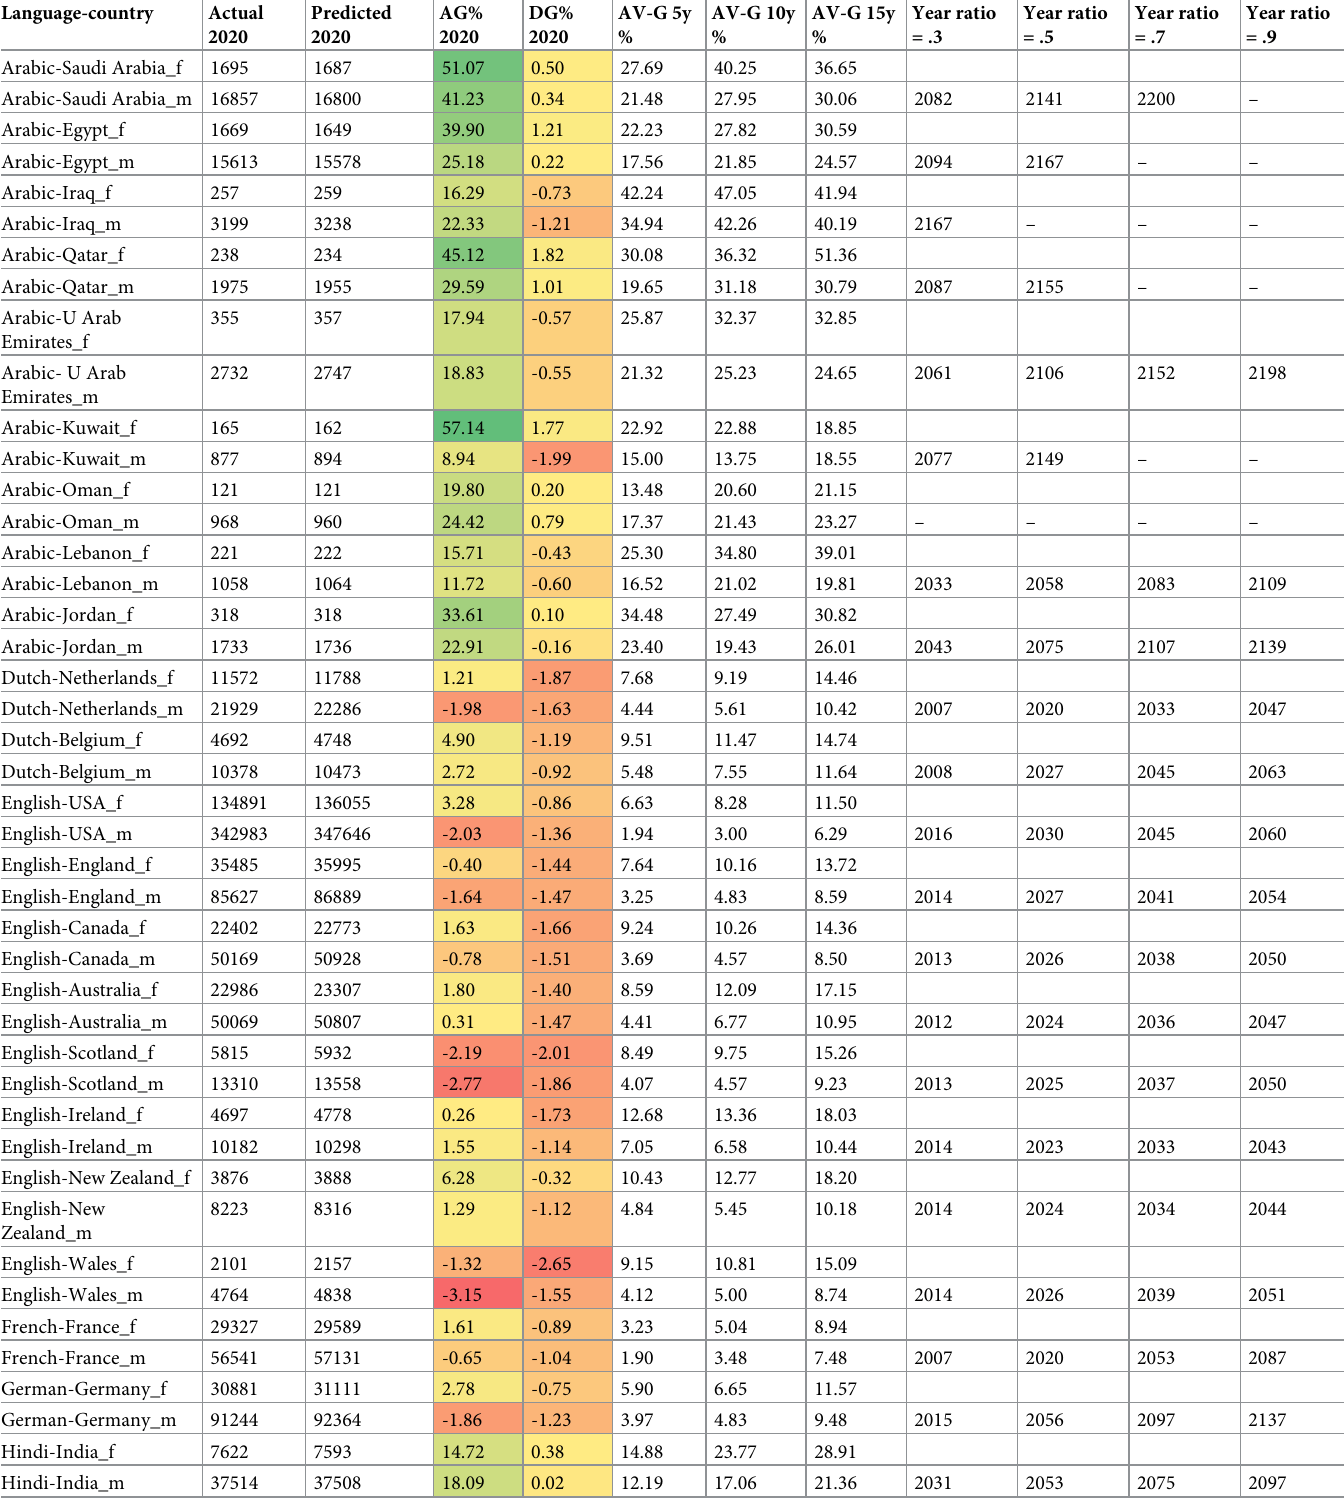
Table 3. Statistics of temporal trends of productivity of male and female scientists based on the A-Z method.